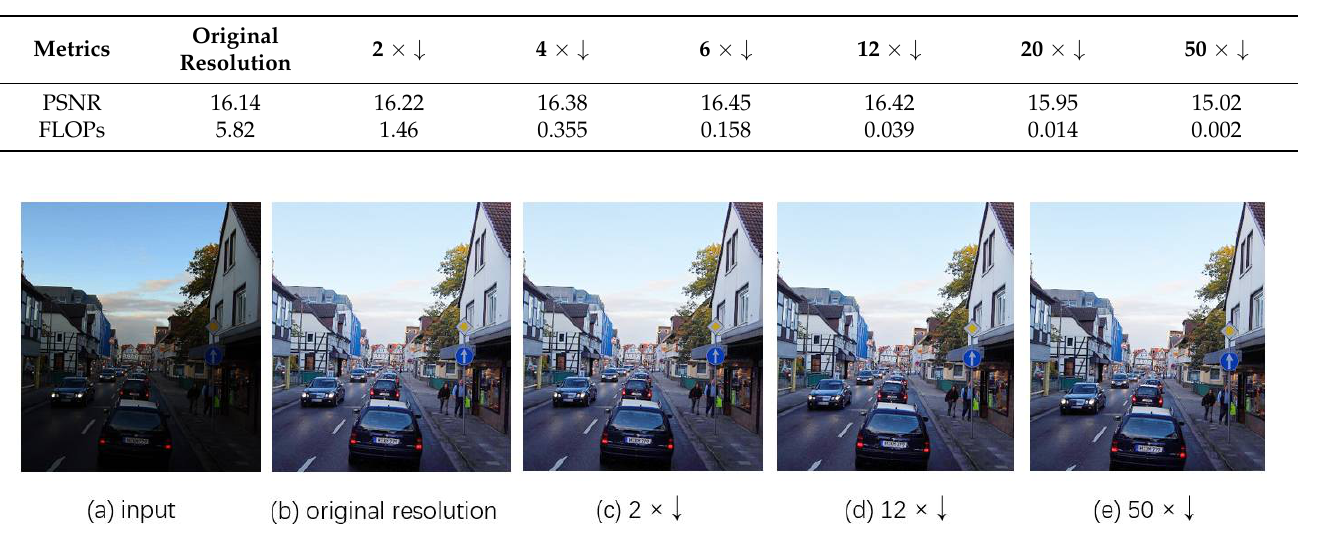
Table 2. Effect of different input image resolutions on image enhancement. The FLOPs (in G) are computed for an image of size 1200 × 900 × 3. “number × ↓ ” indicates the times of downsampling the input image. The test image is from the part2 dataset of SCIE.